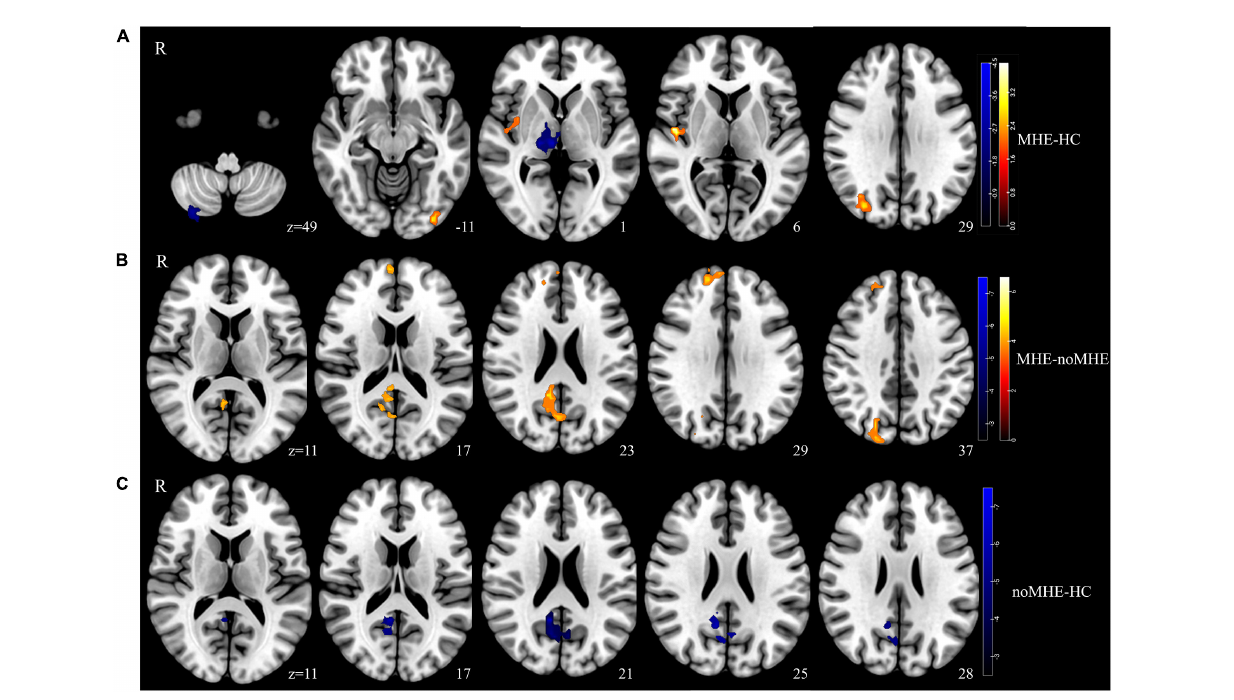
FIGURE1 Group differences in the temporal variability of intrinsic brain activity. (A) Temporal variability of the dynamic amplitude of low-frequency fluctuation (dALFF) between the minimal hepatic encephalopathy (MHE) and healthy control (HC) groups was identified using two-sample t -tests. (B) Significance of dALFF values differences between the MHE and noMHE groups. (C) Significance of dALFF differences between the cirrhosis without MHE (noMHE) and HC groups. The statistical significance level was set at P voxel < 0.005, and P cluster < 0.05 [Gaussian random field (GRF)-corrected, cluster extent threshold at k ≥ 40]. Hot colourss represented increased dALFF, and blue colors represent decreased dALFF.